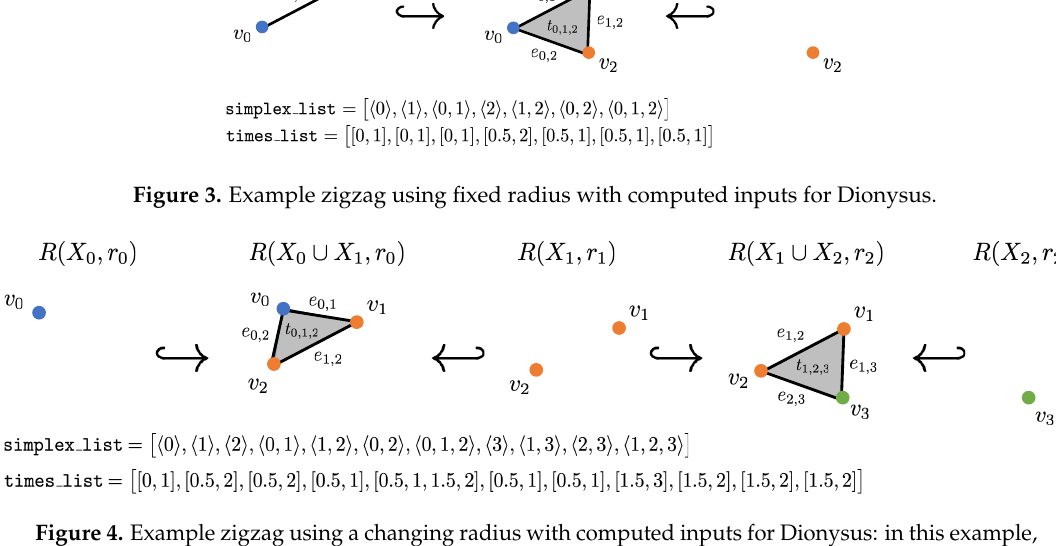
Figure 4. Example zigzag using a changing radius with computed inputs for Dionysus: in this example, r 0 > r 1 and r 2 > r 1